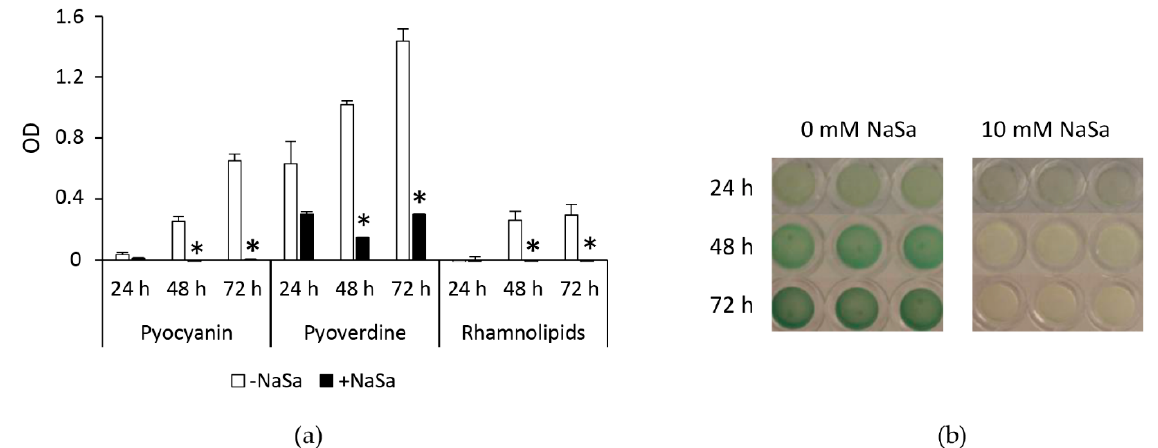
Figure 6. Sodium salicylate (NaSa) reduces PAO1 wt biofilm virulence factor production. ( a ) Pyocyanin, pyoverdine and rhamnolipid production in 24-, 48-, and 72-h-old biofilms formed in the presence or absence of 10 mM NaSa. ( b ) Visual appearance of the biofilms. Mean ± SD, n = 3 (48 h n = 6). * p < 0.05 Student’s two-sided t-test was compared to the control (0 mM NaSa) at the respective time points.